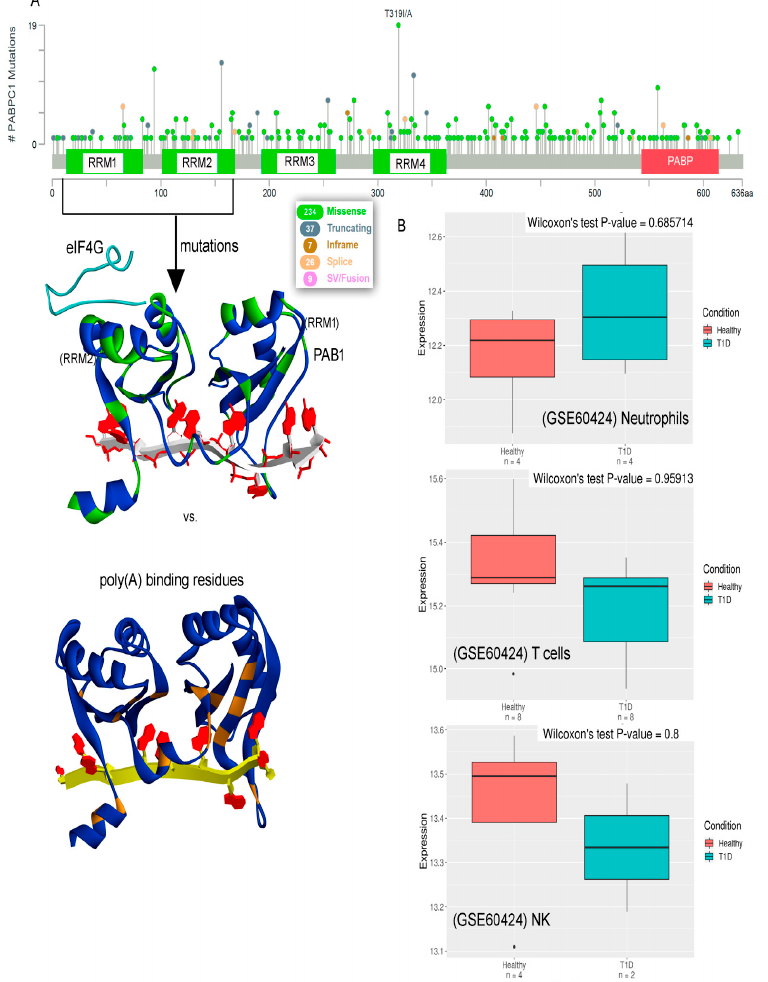
Figure 5. Cancer-derived mutations in the PABPC1 gene. ( A ) The mutation frequency of individual amino acids from different cancer types. Data retrieved from cBioPortal [19]. Residues involved in binding with the poly(A) mRNA from PAB1 were found to be preserved in different cancer types. ( B ) Boxplots representing expression profile of PABPC1 gene within a single dataset (type 1 diabetes (T1D) autoimmune disease; https://adex.genyo.es accessed on 3 November 2022), compared with the control samples (GSE60424, Neutrophils; GSE60424, NK; and GSE60424, T cells [20]).